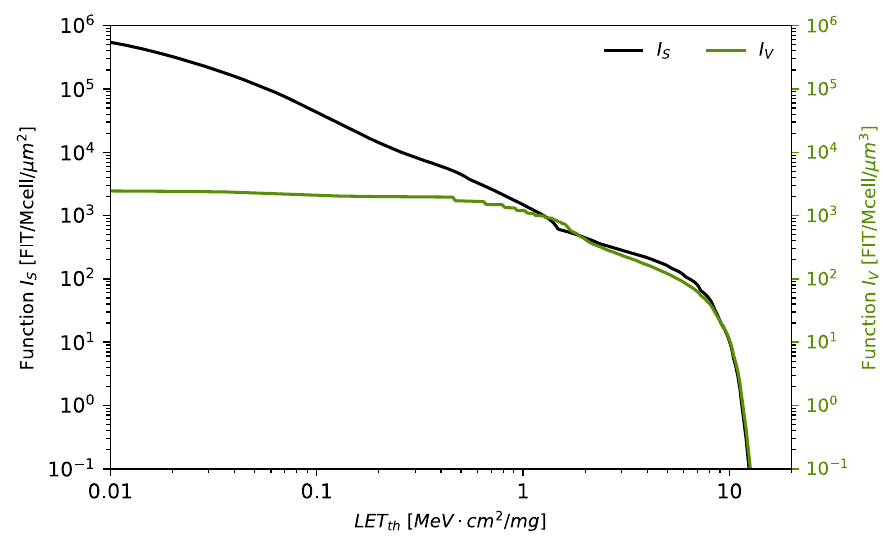
Figure 4. I S and I V as a function of LET for atmospheric neutrons in the 1 MeV–200 MeV energy range. I S (left y-axis) is the contribution to the SER to be multiplied by the visible area of the sensitive volume. I V (right y-axis) is the contribution to the SER to be multiplied by the size of the sensitive volume.